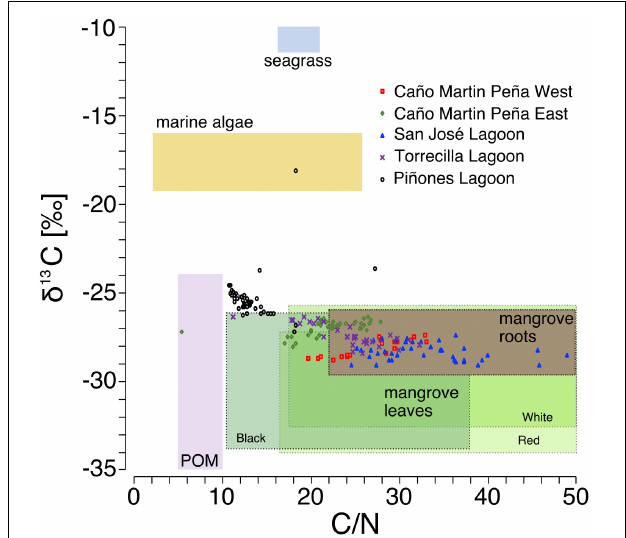
FIGURE 4 | Bi-plot of sediment molar C/N ratio vs sediment C stable isotopes in core sediments relative to potential organic matter sources [source δ 13 C, C/N ratios, and particulate organic matter (POM) based on Khan et al., 2019; Branoff, 2019; Oczkowski et al., unpublished data). Mangrove-derived material was separated into roots and green leaves. Mangrove leaves are further characterized by ranges of C/N ratios and δ 13 C in Red ( Rhizophora mangle L.), White [ Laguncularia racemosa (L.) C.F. Gaertn.], and Black [ Avicennia germinans (L.) L.]